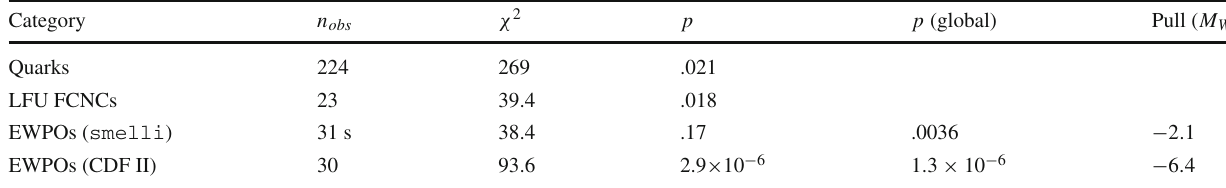
Table 1 SM goodness of fit as calculated by smelli2.3.2 . n obs shows the number of observables in each